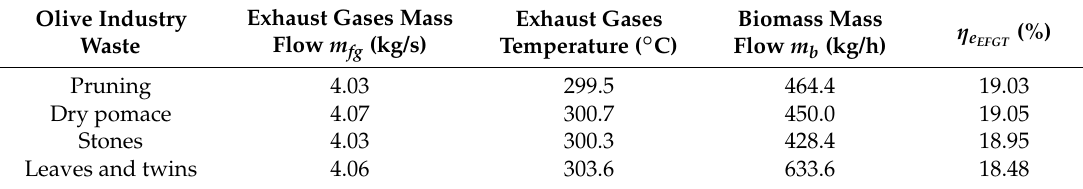
Table 6. Optimum operating conditions of the EFGT for different olive industry wastes and 400 kW of nominal electric